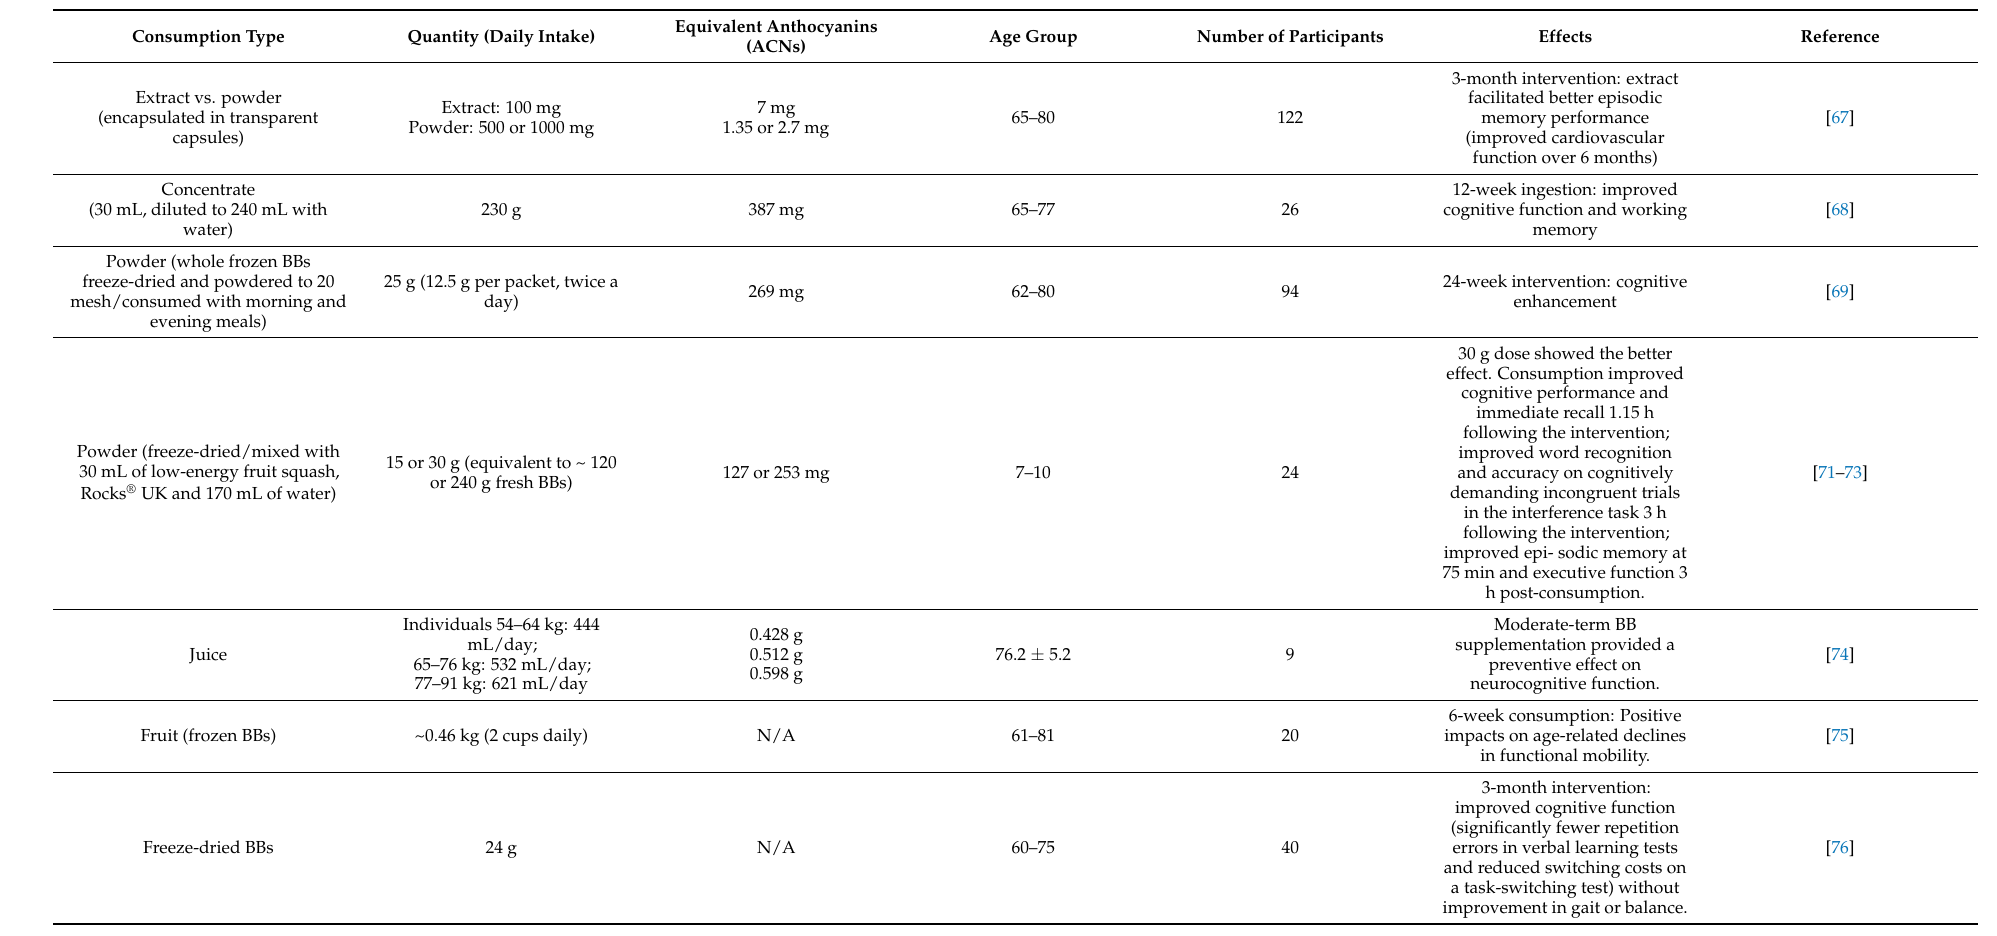
Table 3. Clinical trials on the effects of blueberry consumption on brain